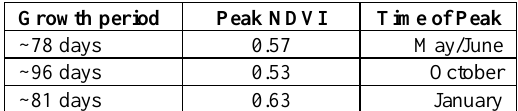
Table 2: Characteristics of 3 potato crops in Deesa